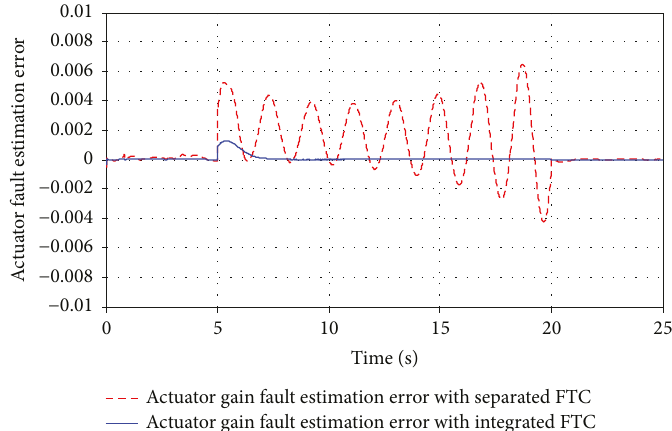
Figure 5: Actuator gain fault estimation